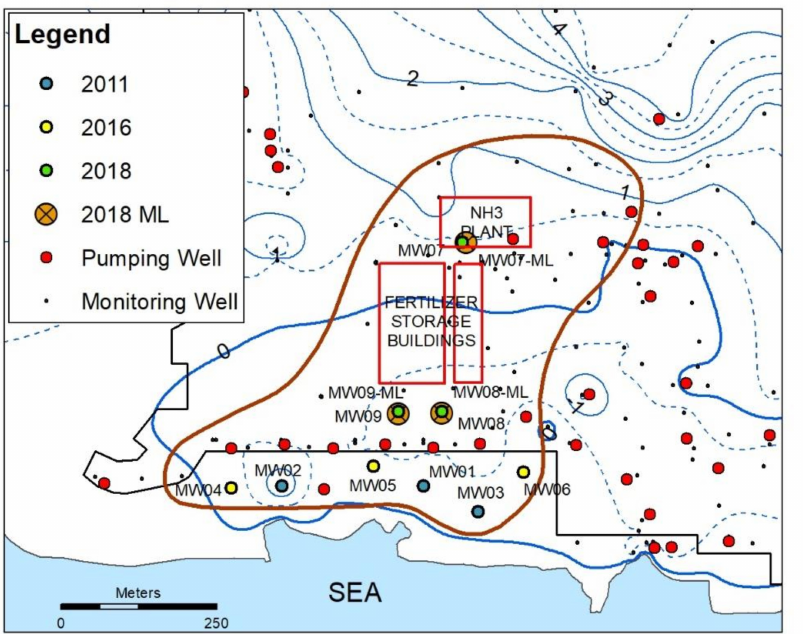
Figure 1. Investigation area (brown full line) of a contaminated coastal aquifer in Southern Italy with more than 70 pumping wells (red) for the pump-and-treat remediation scheme. The fertilizer storage buildings are presumed to be the source zone (red squares). The monitoring wells (MWs) are sampled in 2011 (blue), 2016 (yellow) and 2018 (green). Sediment cores were obtained at MW07, MW08 and MW09 in 2018 (brown, 2018 ML). Blue full and dashed lines represent iso-piezometric contour lines (0.5 m spaced